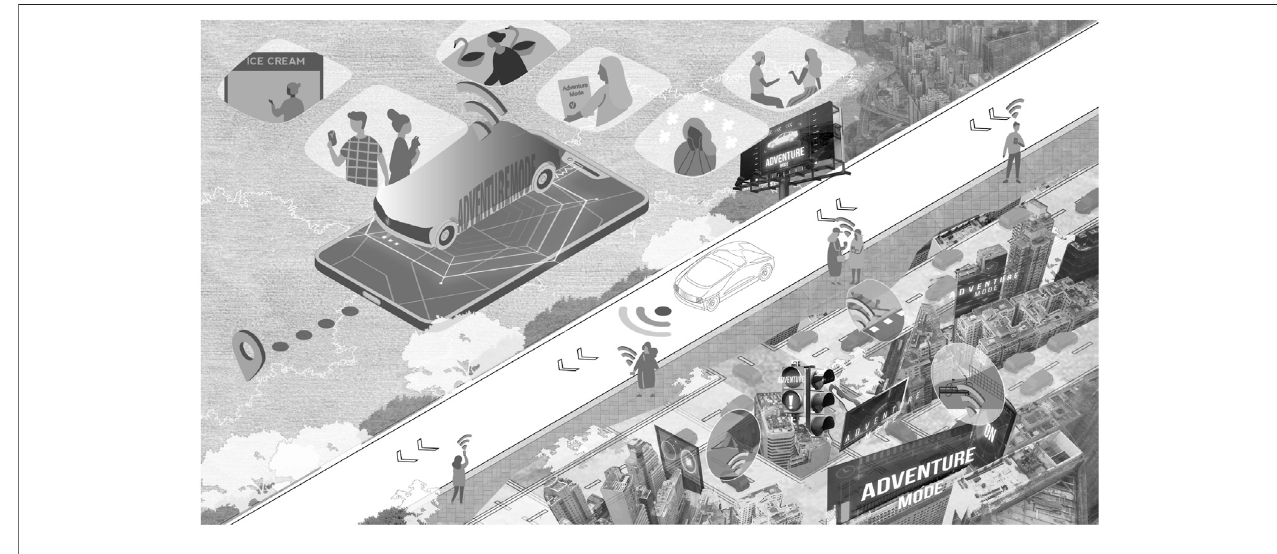
FIGURE 1 | Adventure Mode (image by Hanwen Chen).